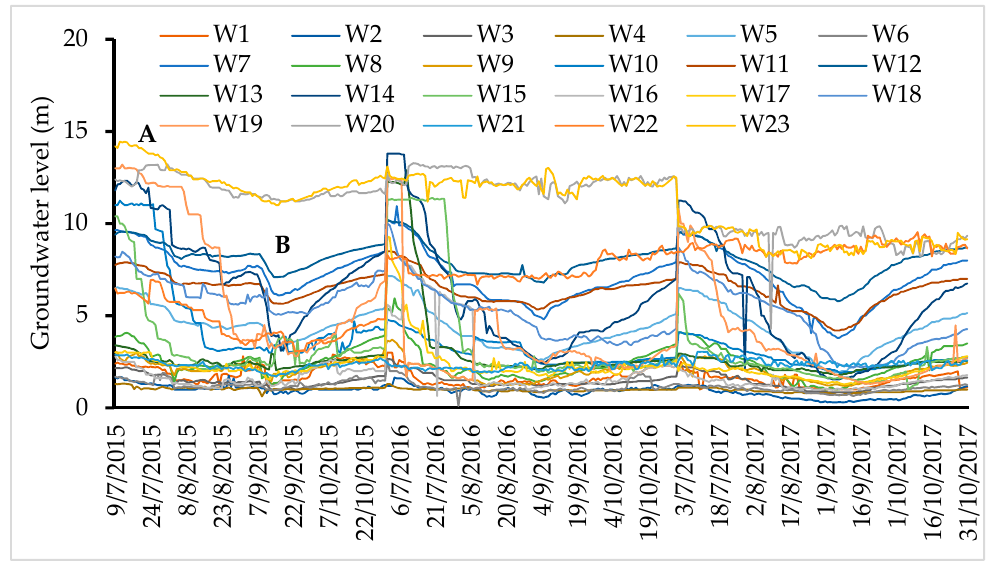
Figure 4. Daily shallow groundwater level variation of all monitoring wells (2015–2017). “A” refers to the dry season and “B” refers to the wet season. The letter “W” stands for wells. The altitude varies for the wells: W1 to W10 (2035 to 2050 AMSL), W11 to W20 (2050 to 2100 AMSL), and W21 to W23 (up to 2123 AMSL).